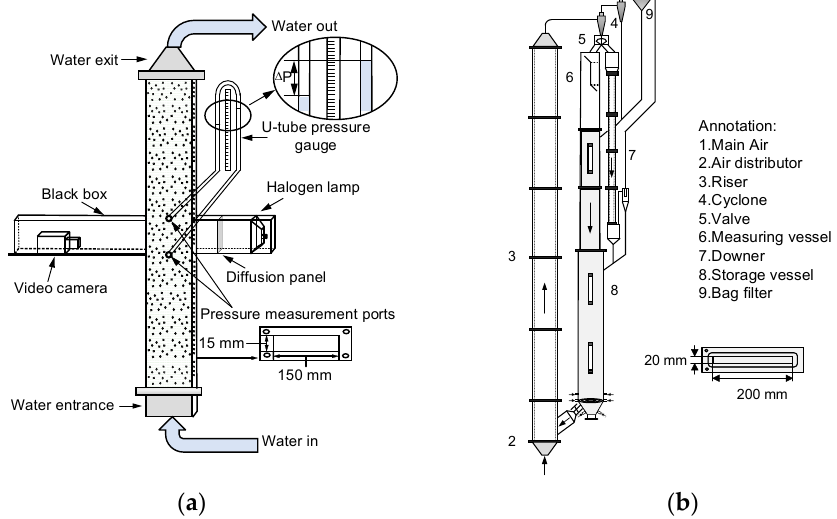
Figure 2. Original image of particle flow in liquid ‐ solid fluidized bed and its grayscale histogram. ( a ) Original image. ( b ) Grayscale histogram.